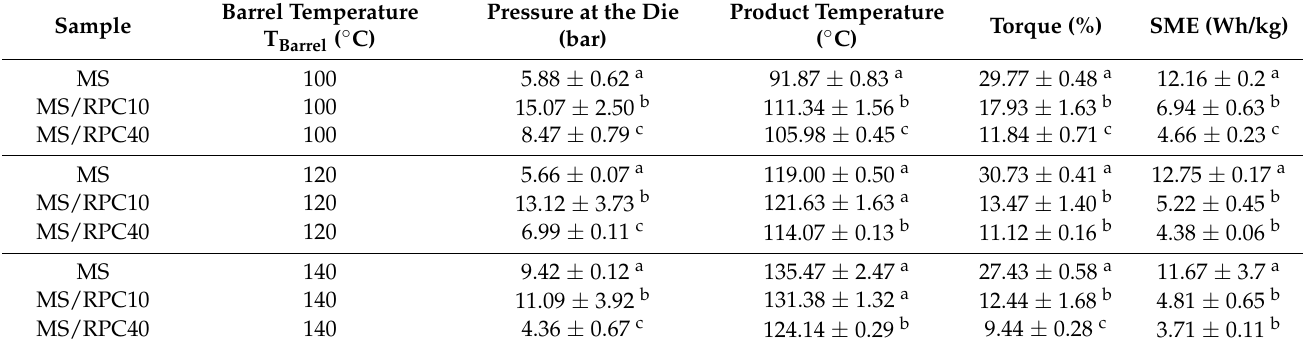
Table 2. Extruder response parameters (pressure at the die, product temperature, torque and specific mechanical energy input (SME)) as a function of barrel temperature (T Barrel = 100, 120, 140 °C) of maize starch (MS) blended with 10 or 40 g/100